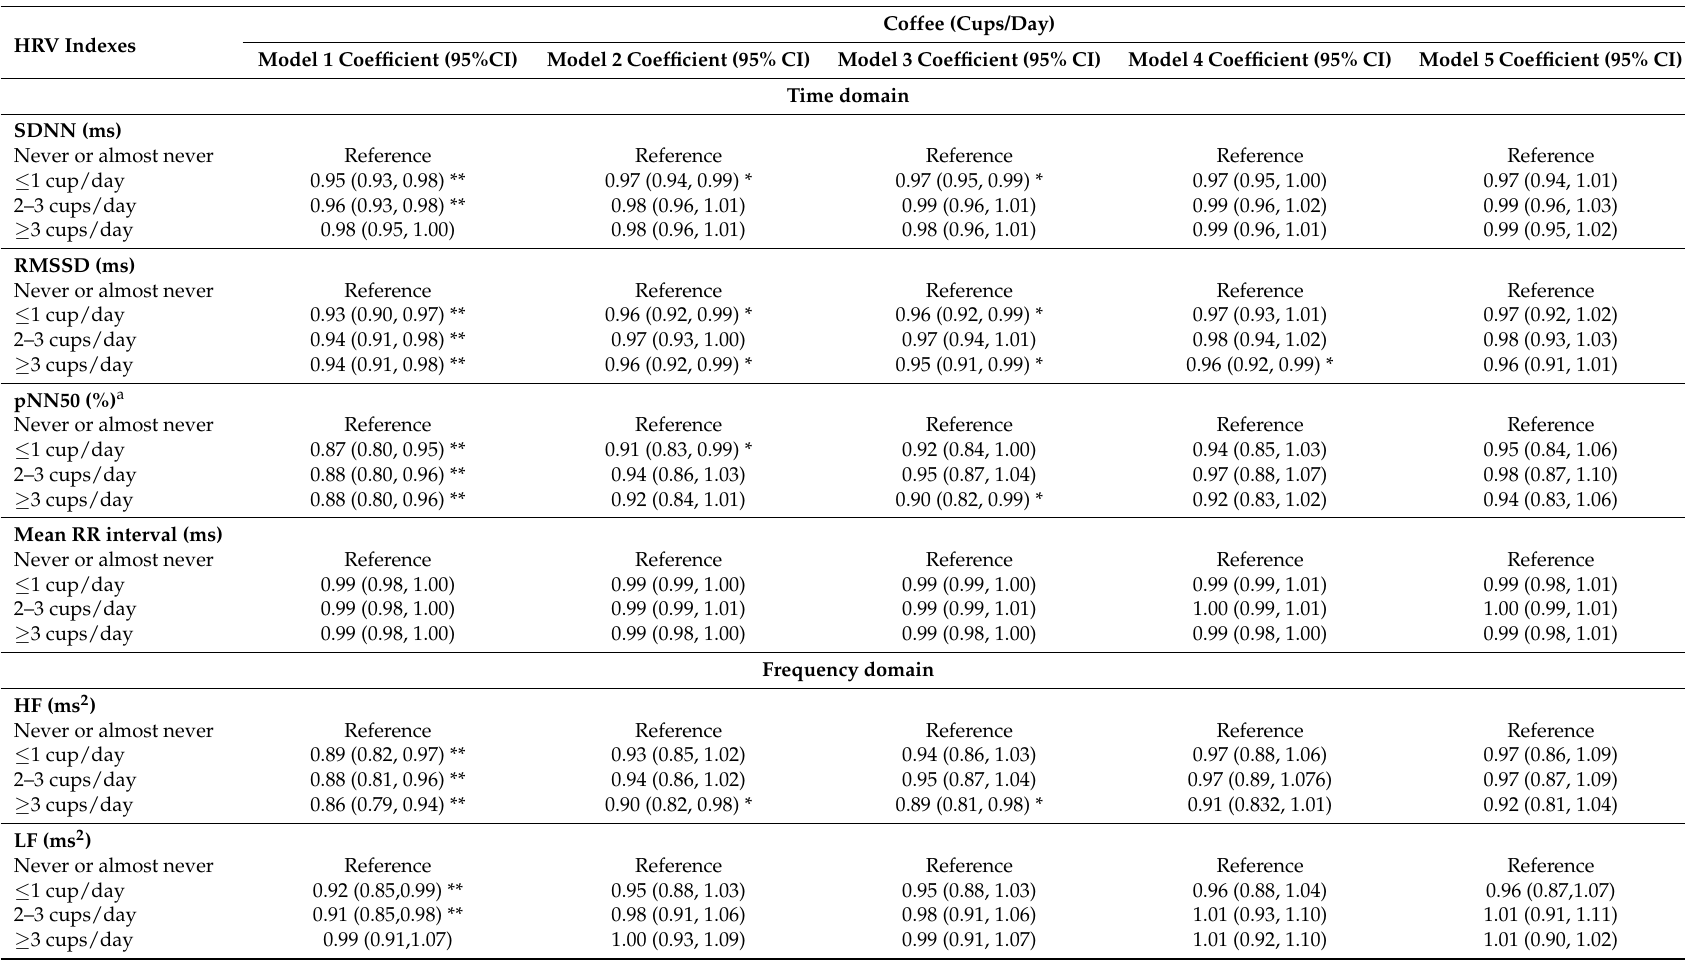
Table 3. Associations of coffee consumption frequency and heart rate variability indexes of participants (35 to 74 years of age) of ELSA-Brasil